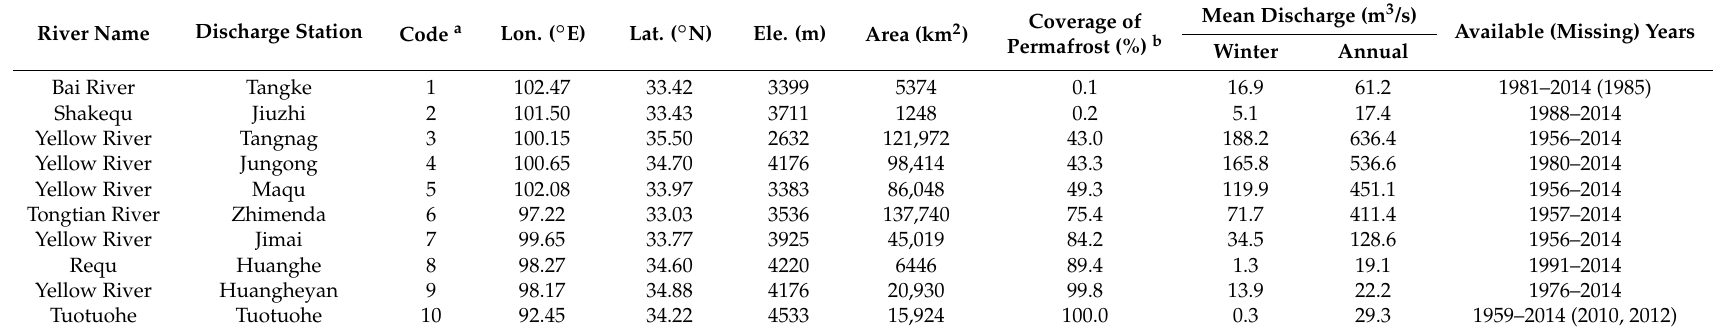
Table 1. General information about the discharge stations/catchments.